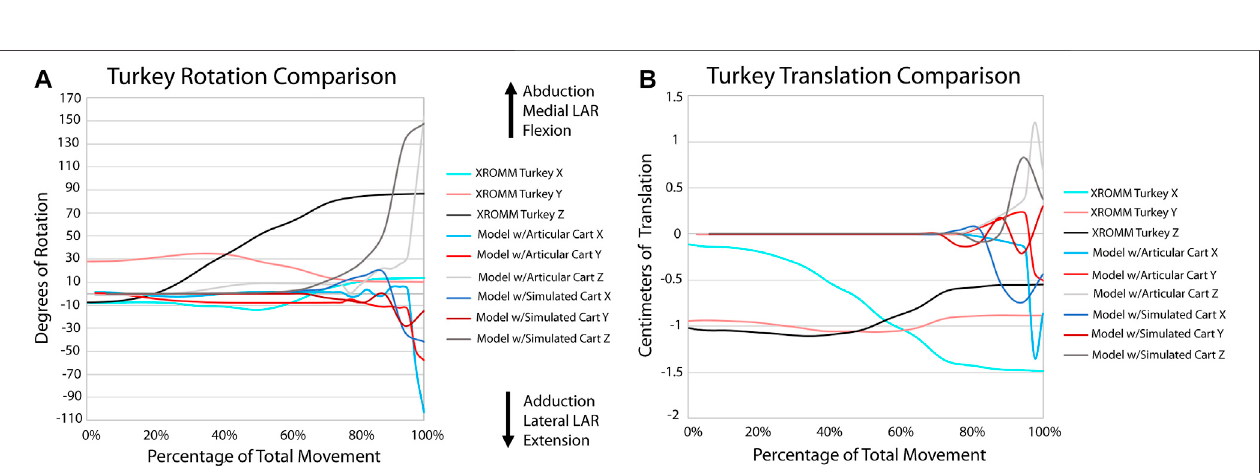
FIGURE6| Comparison ofkinematic dataoftheturkey simulations and XROMM analysis. (A) Comparison ofrotational data. (B) Comparison oftranslationaldata.